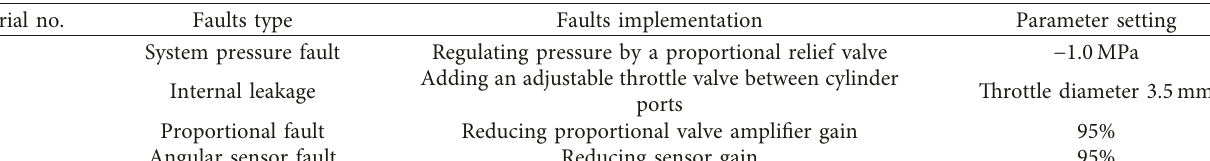
Table 2: Common faults implementation scheme.